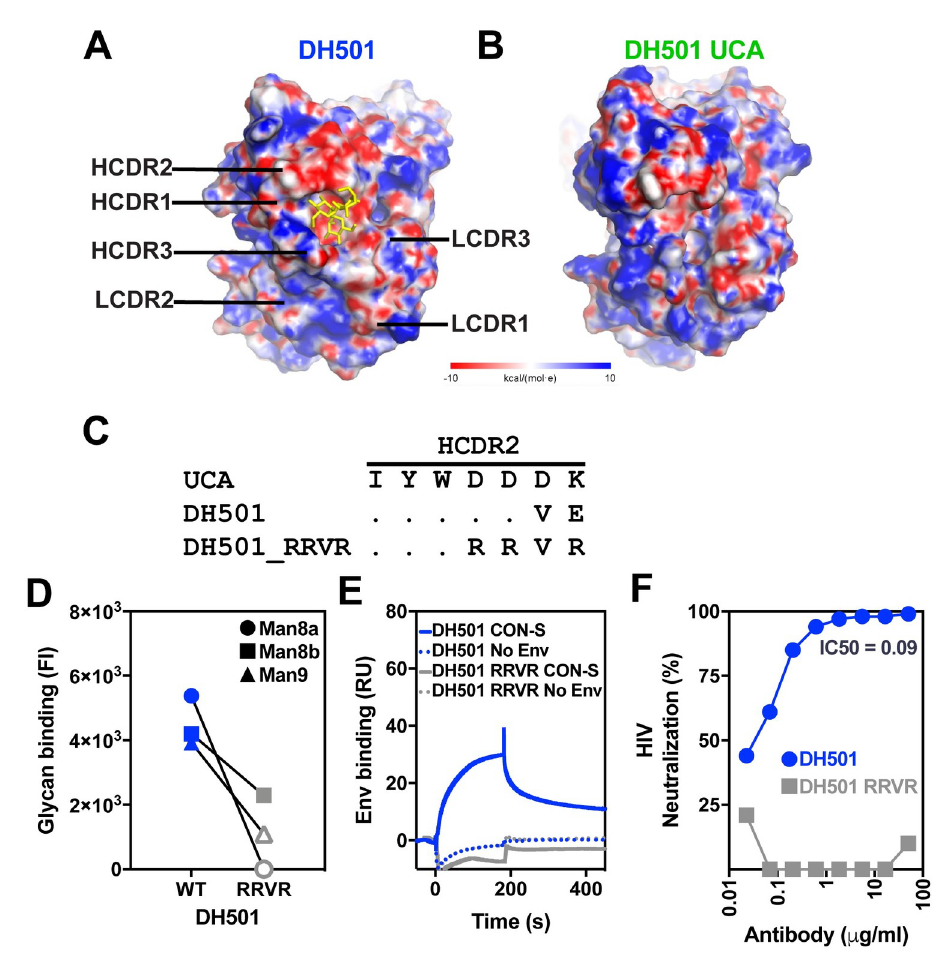
Fig 5. The negatively charged amino acid patch in HCDR2 is required for HIV-1 Env trimer binding. (A, B) The electrostatic surface potential of ( A ) DH501 and ( B ) the DH501 UCA. The glycan binding pocket of the DH501 antibody has a negative charge. The terminal mannose residues of the D2 arm of Man 9 GlcNAc 2 are shown in yellow. The electrostatic potentials are oriented with the paratope facing towards the viewer. ( C ) Amino acid alignment of HCDR2 of DH501 and the DH501 UCA. Dots indicate identical residues. The negatively-charged residues within the HCDR2 of DH501 were changed to positively-charged arginine residues (RRVR). ( D ) DH501 wildtype (WT) and the DH501_RRVR variant (RRVR) IgG binding to high mannose glycans in a custom luminex assay. The mean of 3 independent experiments is shown. Positive glycan binding values are shown as filled symbols. Positivity threshold for 7, 8a, 8b, and 9 was 1.8x10 3 for each glycan. ( E ) DH501 and DH501_RRVR IgG binding to soluble, trimeric CON-S SOSIP gp140s (solid line). Dashed lines show binding magnitudes in the absence of Env. Images are representative of two independent experiments. (F) DH501 and DH501_RRVR IgG in vitro HIV-1 neutralization of Man 9 GlcNAc 2 - enriched JR-FL.